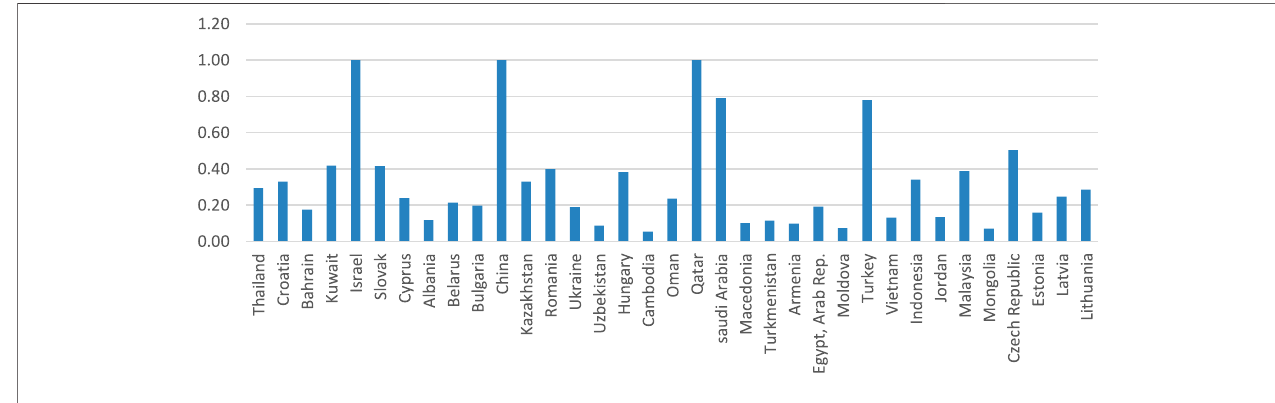
FIGURE 3 | Sensitivity